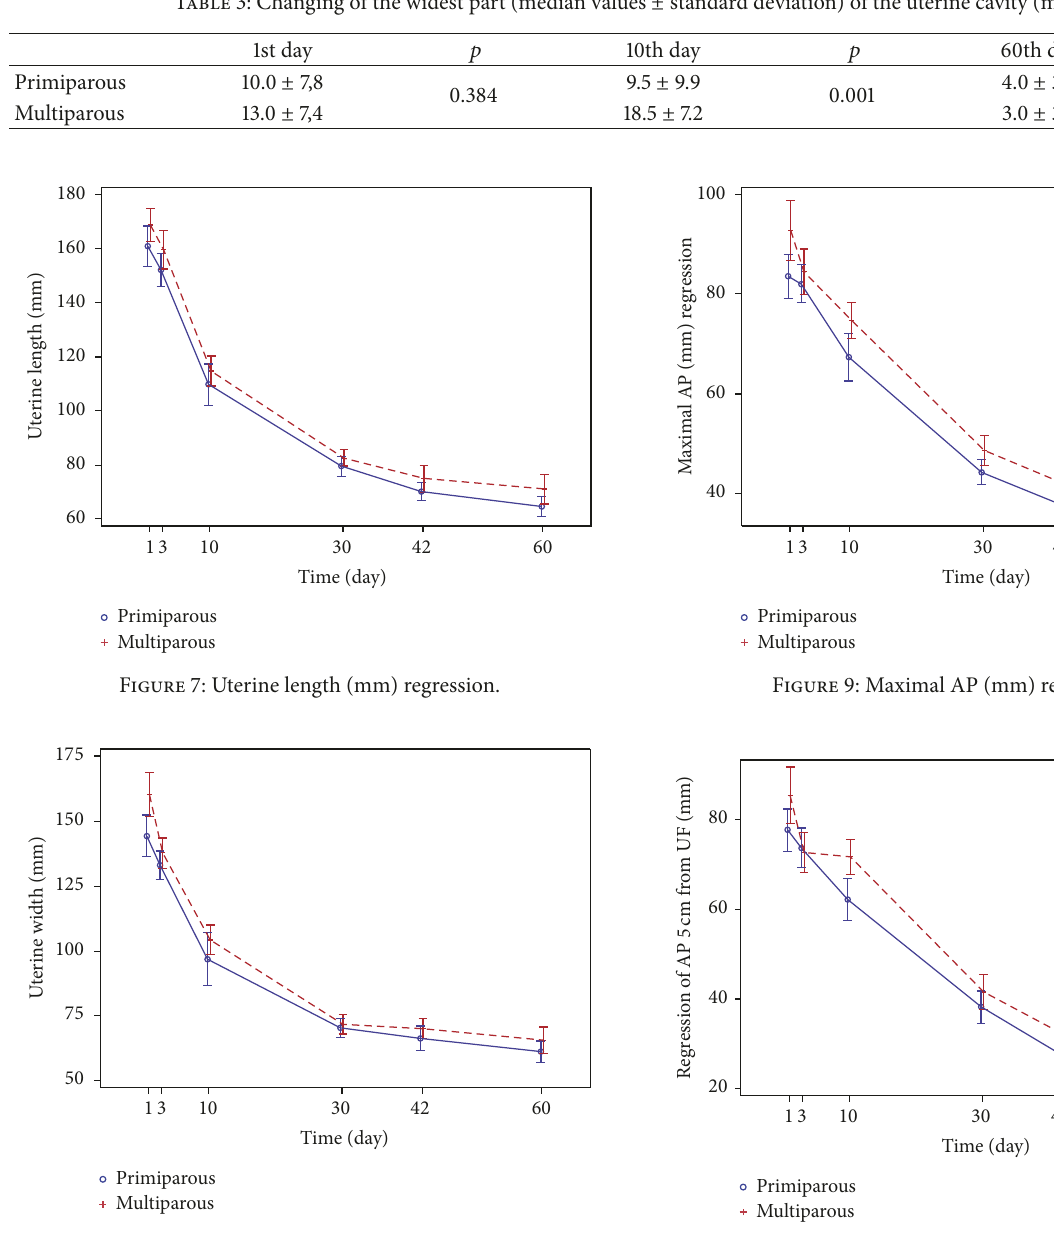
Figure 8: Uterine width (mm) regression.